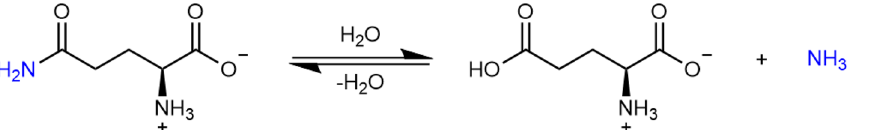
Scheme 1. Decomposition of glutamine, releasing